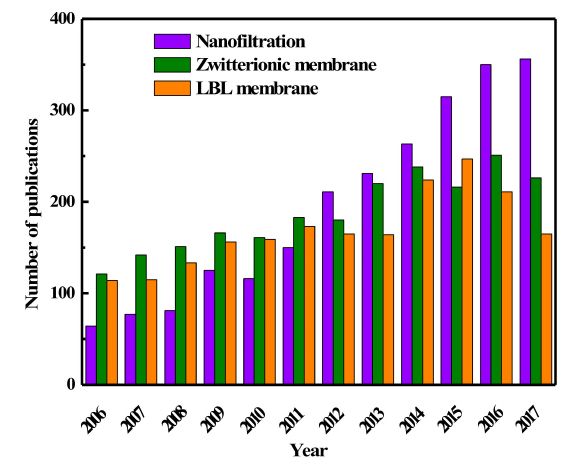
Figure 2. Record of the number of papers published in indexed journals between 2006 and 2015 containing the keywords “nanofiltration” or “zwitterionic membrane” or “layer by layer (LBL)